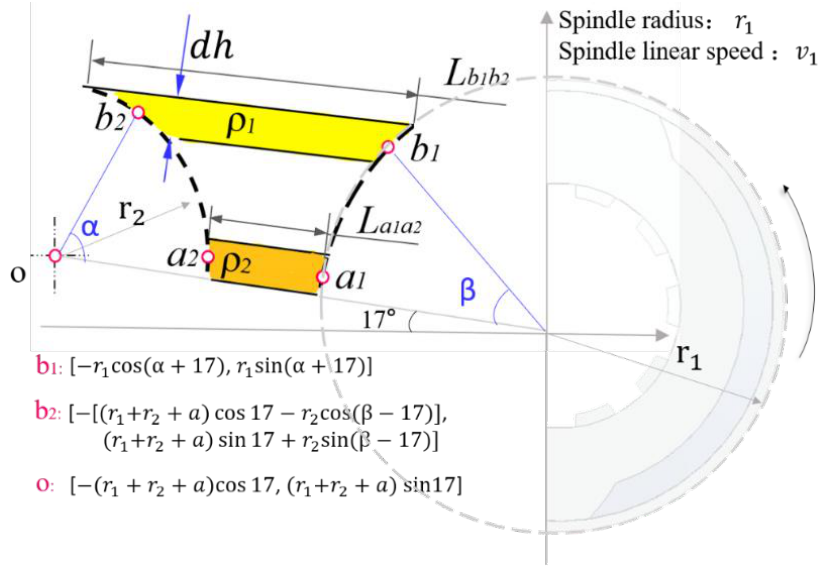
Figure 3. Kinematic analysis of straw feeding.